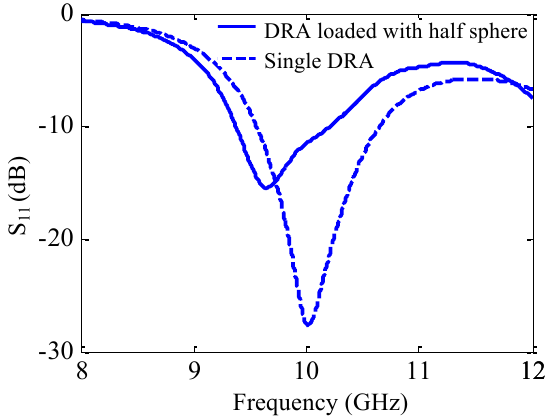
Figure 11: Reflection coefficient versus frequency for DRA loaded with upper half dielectric sphere compared to single